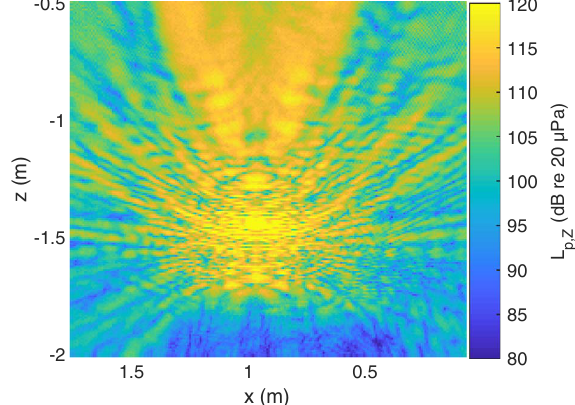
Figure 7. Z -weighted equivalent continuous sound pressure levels time-averaged over 2 s L p , Z ,eq 2 s of the one-third octave band with a center frequency of 20 kHz in a vertical plane 24 cm in front of the sonotrode ( S Figure 7 : y = (cid:1) 0.80 m) with a spatial resolution of 1